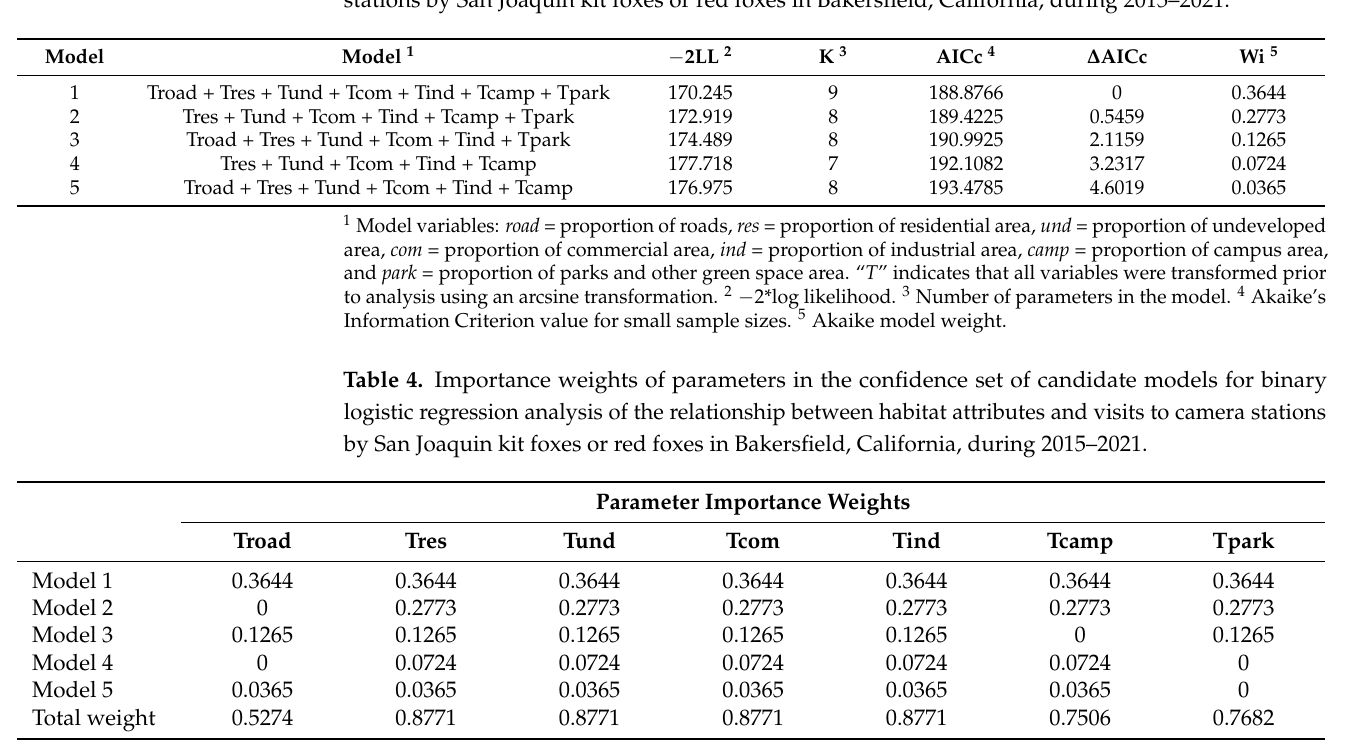
Table 3. Confidence set of candidate models and associated Akaike Information Criterion values for binary logistic regression analysis of the relationship between habitat attributes and visits to camera stations by San Joaquin kit foxes or red foxes in Bakersfield, California, during 2015–2021.